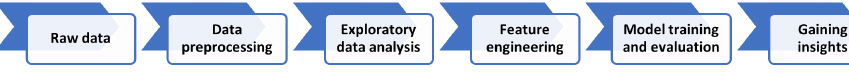
Figure 9. Machine learning